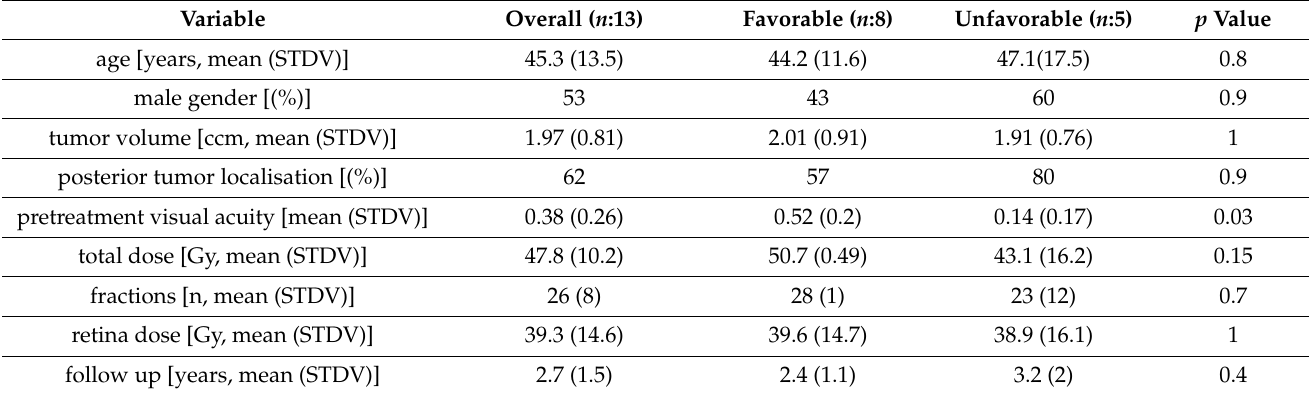
Table 1. Mean pretreatment epidemiological and clinical variables with their standard deviation (STDV) or the percentage of the variable, overall and dichotomized (favorable outcome with improvement of the acuity vs. unfavorable outcome with stable or worsening of the acuity) p value of the Mann–Whitney test or Fisher’s exact test between the favorable and unfavorable